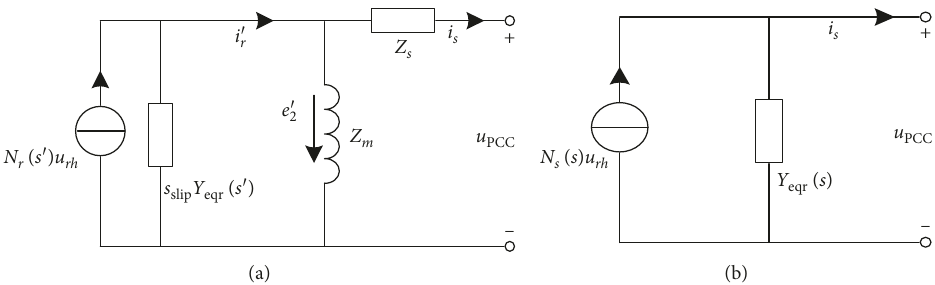
Figure 5: Norton equivalent circuit of the rotor-side converter: (a) detailed circuit of the rotor-side converter and asynchronous machine; (b) equivalent model. Table 1: Detailed parameters of the DFIG simulation platform. Parameters Values